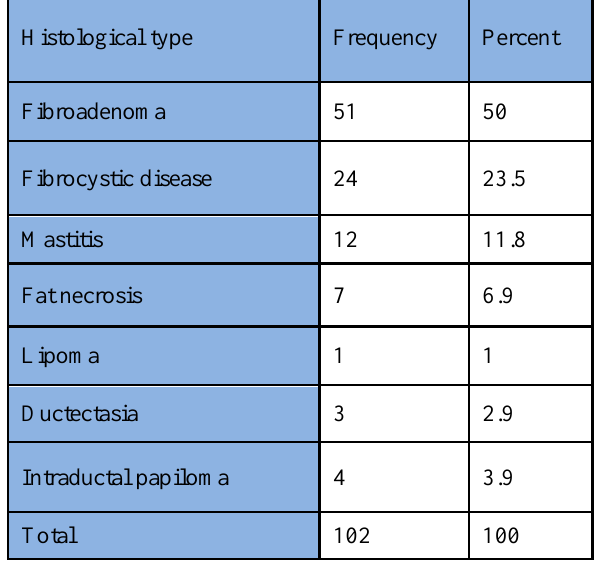
Table 3 The histological types of diagnosed benign beast diseases Histological type